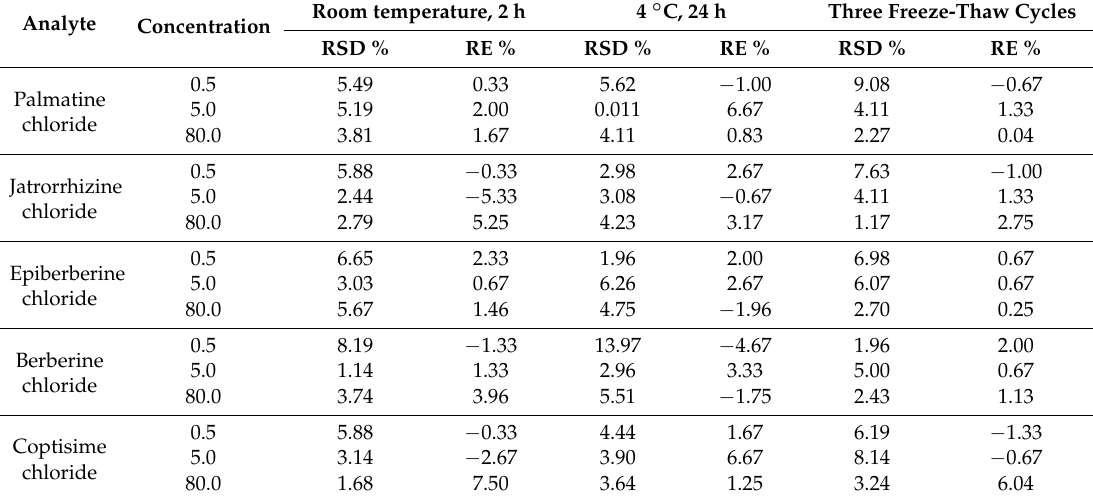
Table 4. The stability of five analytes in plasma at three quality control (QC) concentration